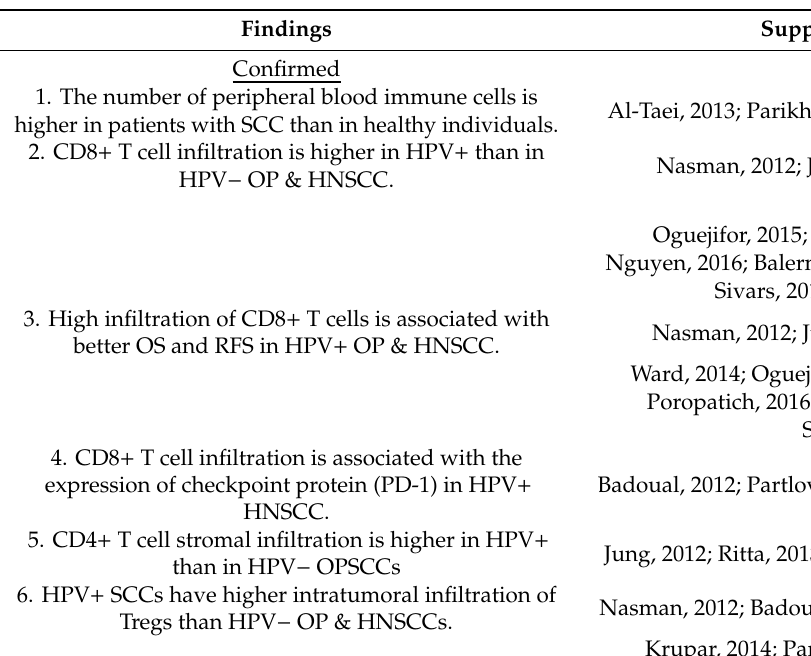
Table 7. Summary of evidence and